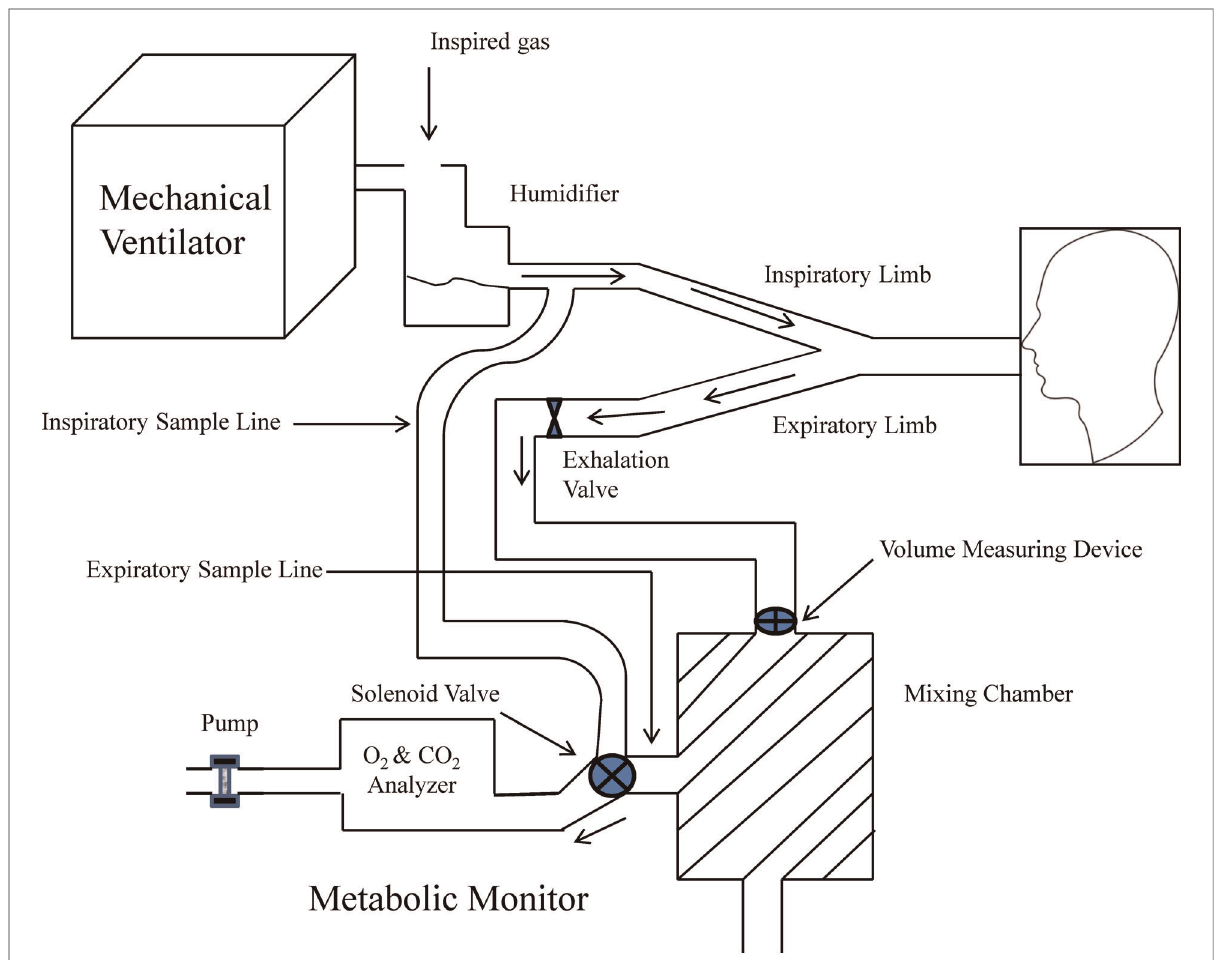
FIGURE 1 Graphic representation of metabolic equipment with mixing-chamber and its interface with mechanical ventilation. Modi fi ed from Weissman and Kemper